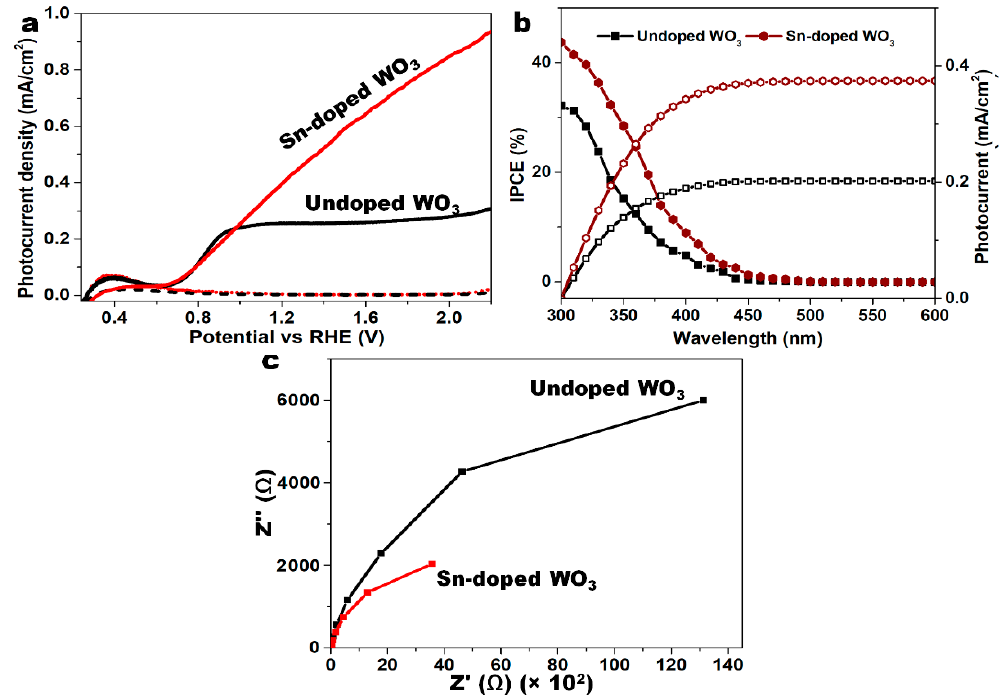
Figure 8. ( a ) Linear sweep voltammetry (LSV) plots (dotted lines indicated LSV measured in the dark), ( b ) incident photon-to-current efficiency (IPCE) and integrated IPCE, and ( c ) Nyquist plots of the undoped and Sn-doped WO 3 thin films measured in 0.5 M Na 2 SO 4 .